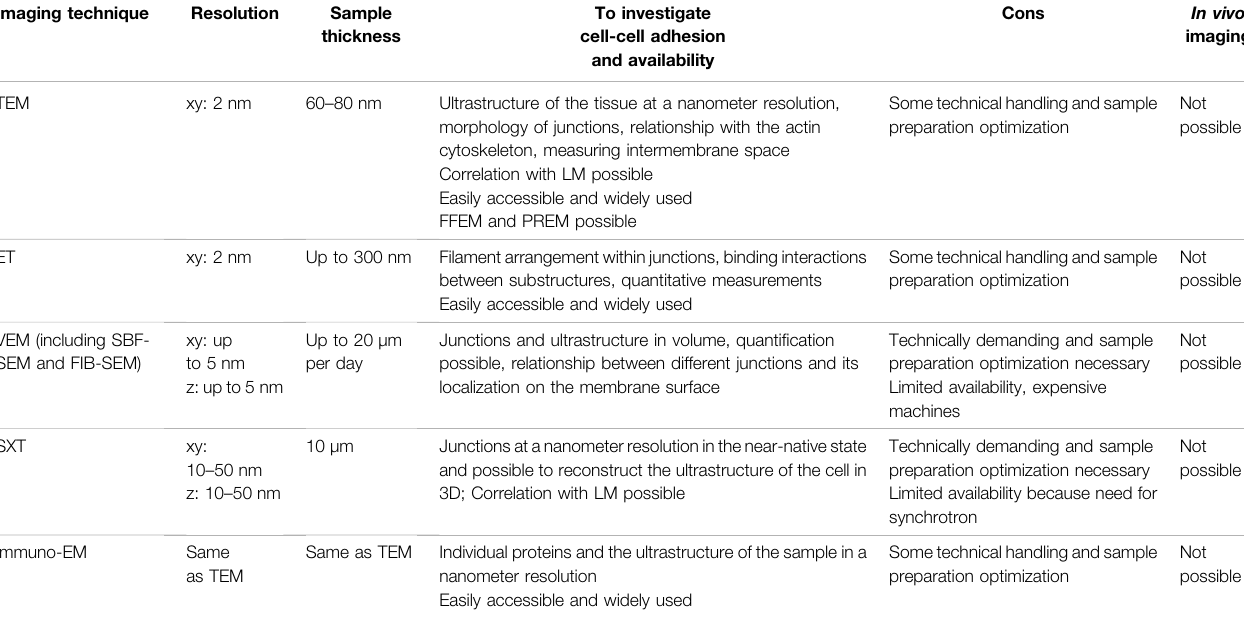
TABLE 2| Anoverview oftheimagingtechniquesused tostudythestructure and compositionofcell-celladhesions withelectron andX-raymicroscopy;TEM:transmission electron microscopy; FFEM: freeze-fracture electron microscopy; PREM: platinum replica electron microscopy; ET: electron tomography; VEM: volume electron microscopy; SBF-SEM: serial block face scanning electron microscopy; FIB-SEM: focused ion beam scanning electron microscopy; SXT: soft X-ray tomography; immuno- EM: immuno electron microscopy. Imaging